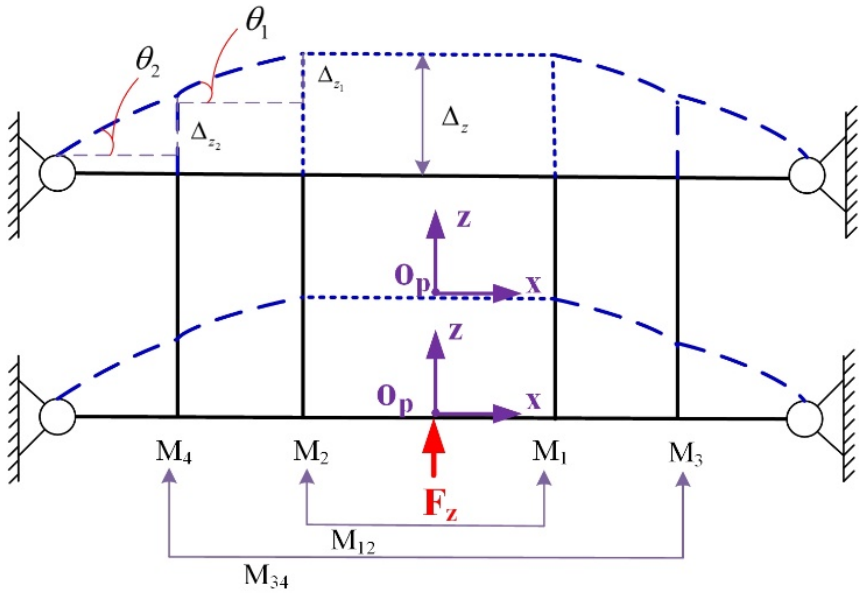
Figure 3. Schematic of moving principles of the high-rigidity four bar (HRFB) mechanism.